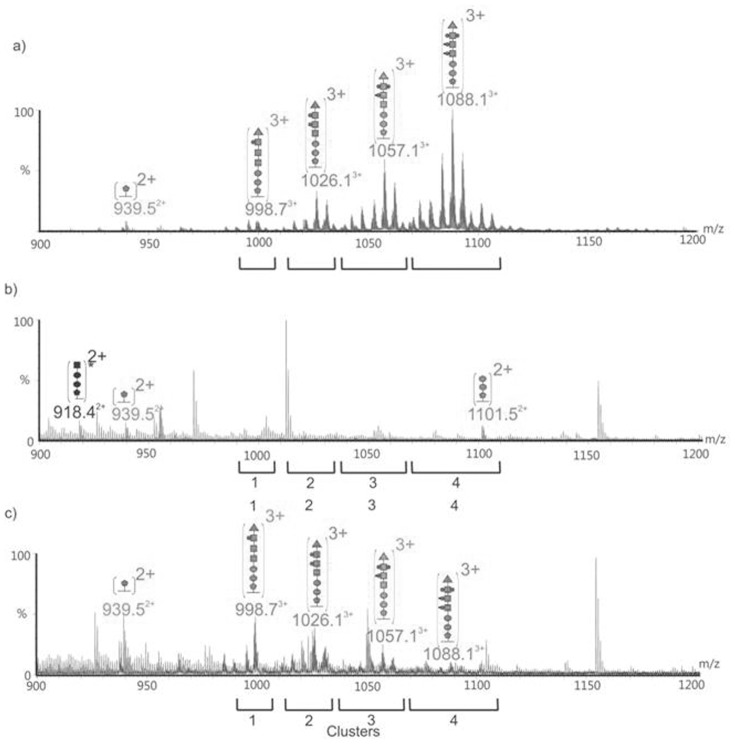
nLC-MS alignment of AH-3 polar flagellin FlaB glycopeptide.The 1501 Da FlaB peptide MTSAFTISGIASSTK (eluting between 17.9 and 18.9 minutes) was modified by the same heptasaccharide glycan with HexNAc residues additionally variably modified by phosphate and methyl groups [9]. These additional variable modifications resulted in four major glycopeptide ion cluster regions, as indicated below each spectrum. The cluster number corresponds to the number of additional phosphate groups modifying the heptasaccharide, and peaks within that cluster possess a variable number of additional methyl groups. Only the most prominent peak within each cluster is annotated. a) Wild type polar flagellin. The heptasaccharide modification was the most abundant form of modification, with only minor amounts of peptide harbouring the 376 Da sugar were observed. The glycopeptide peak intensity increases with the addition of each phosphate group to the glycans. b) AH-2767 gne mutant polar flagellin. In this mutant, the FlaB peptide showed only minor modification with intermediate glycan chains. The unmodified peptide and peptide modified only with the 376 Da sugar were also not observed at high levels. c) AH-3ΔWecP mutant polar flagellin. In contrast to wild type, the predominant modification in AH-3ΔWecP was a single 376 Da sugar. Clustering resulting from the heptasaccharide and additional variable modification similar to that observed in wild type polar flagellin was observed, but with decreased intensity as compared to the monosaccharide modification. Figure legend: solid pentagon = 376 Da sugar; • = hexose; ▪ = HexNAc; ▴ = 102 Da unknown moiety; • = phosphorylation; ▪ = methylation; * = truncated peptide.